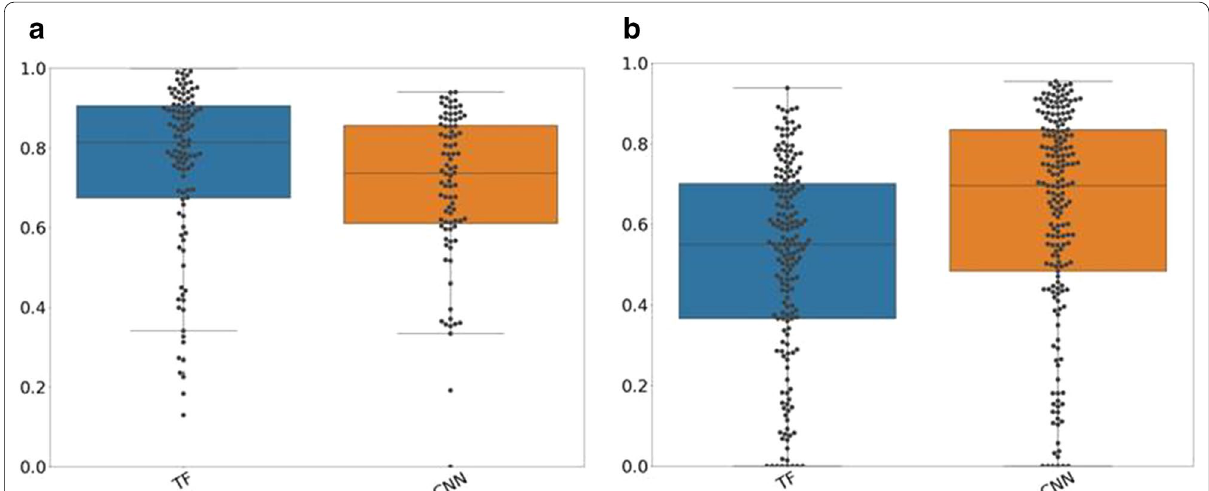
Fig. 5 Jaccard coefficient (JC) values dependent on lesion size: JC values for bigger (left figure) and smaller (right figure) lesions for both AI-based segmentation approaches